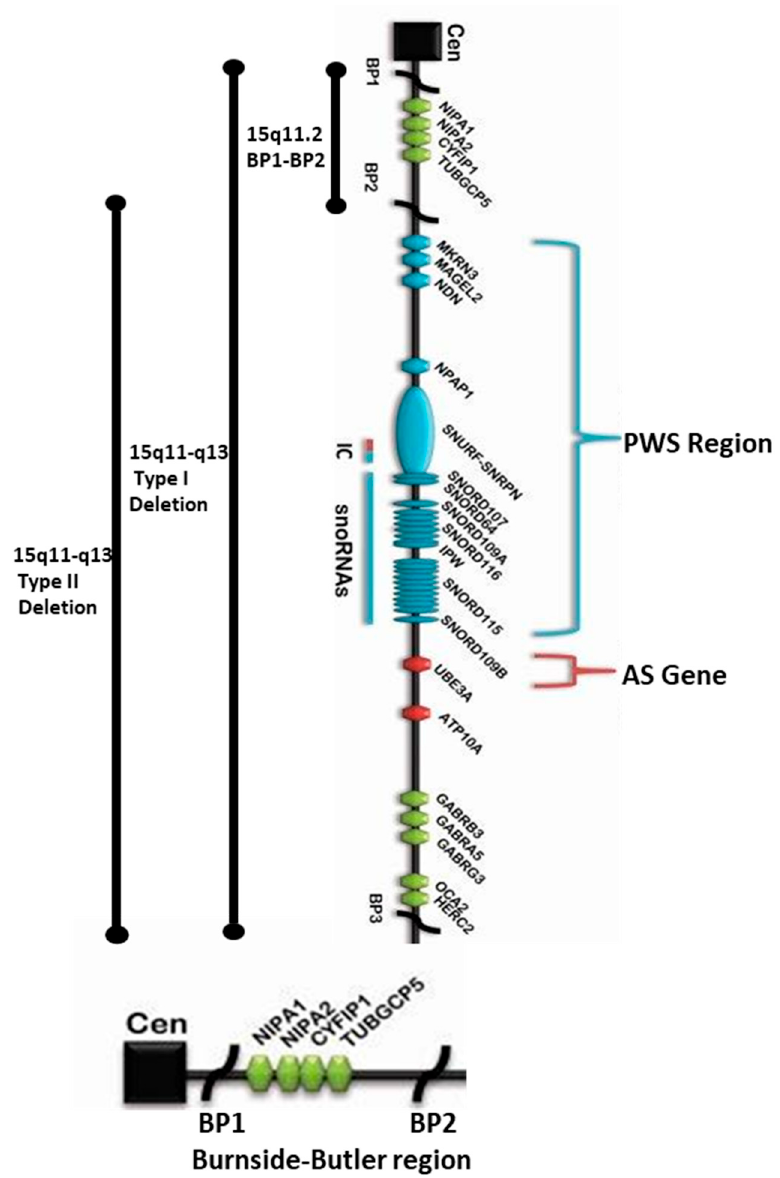
Figure 1. 15q11.2 BP1-BP2 microdeletion ( Burnside–Butler ) syndrome region found at the proximal end of Prader–Willi syndrome (PWS) / Angelman syndrome (AS) regions within the 15q11-q13 Type I deletion depicting the location and order of the four protein-coding genes therein: NIPA1 , NIPA2 , CYFIP1 , and TUBGCP5 within the 15q11.2 region distal to the centromere and proximal to the imprinted PWS / AS genes. The bottom enlarged horizontal chromatin figure exclusively depicts NIPA1 , NIPA2 , CYFIP1 , and TUBGCP5 genes in the BP1-BP2 region.